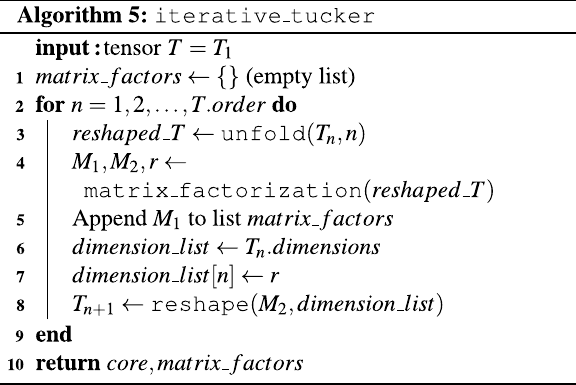
Tucker algorithm. A Tucker network for a tensor of order d , dimensions n 1 , . . . , n d , and ranks r 1 , . . . , r d is a product of an order- d tensor with dimensions r 1 , . . . , r d and d matrices with dimensions r i × n i , as shown on Fig. 1. Our Tucker decomposition algorithm also comes in two flavors, an iterative and a recursive variant. Algorithm 5 presents the iterative version. Its input consists of a tensor T to be factored, and a desired rank r . The algorithm works by iterating through all possible orders from 1 to T . order . At the n ’th iteration, the current tensor T n is reshaped into a matrix, which is then factored into a product M 1 · M 2 with the help of Algorithm 3. The first (smaller) factor M 1 is appended to the list of factors (initialized with the empty list at the start), which the algorithm returns upon termination. The second factor M 2 is reshaped appropriately again into a matrix, and subsequently factored at the next